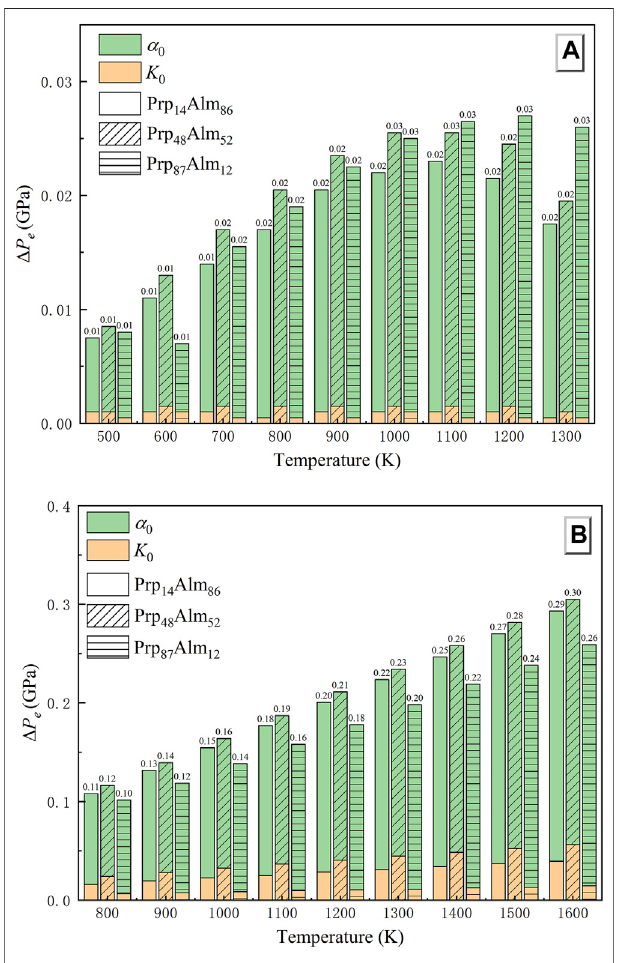
FIGURE 7 | The total uncertainty of the thermal equation of state parameters on the results of P e . (A) : Garnet-quartz elastic barometer; (B) : Diamond-garnet elastic barometer.